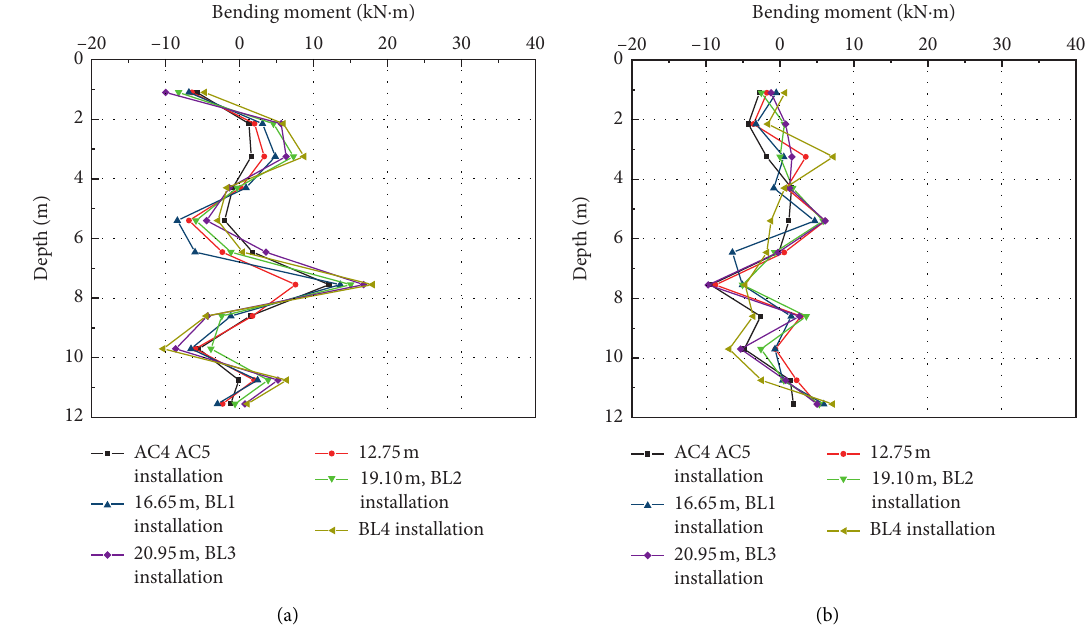
Figure 6: Bending moment of piles during the second-order excavation. (a) Test pile 1. (b) Test pile